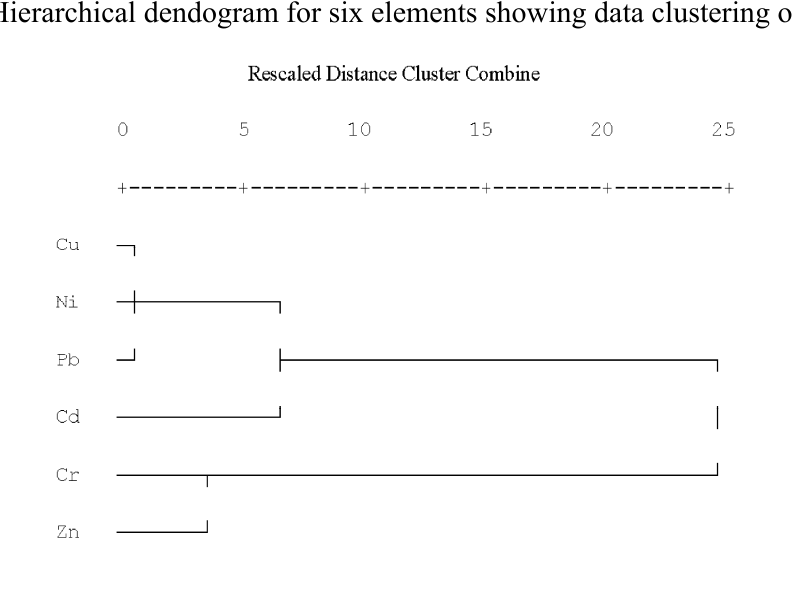
Figure 7. Hierarchical dendogram for six elements showing data clustering of